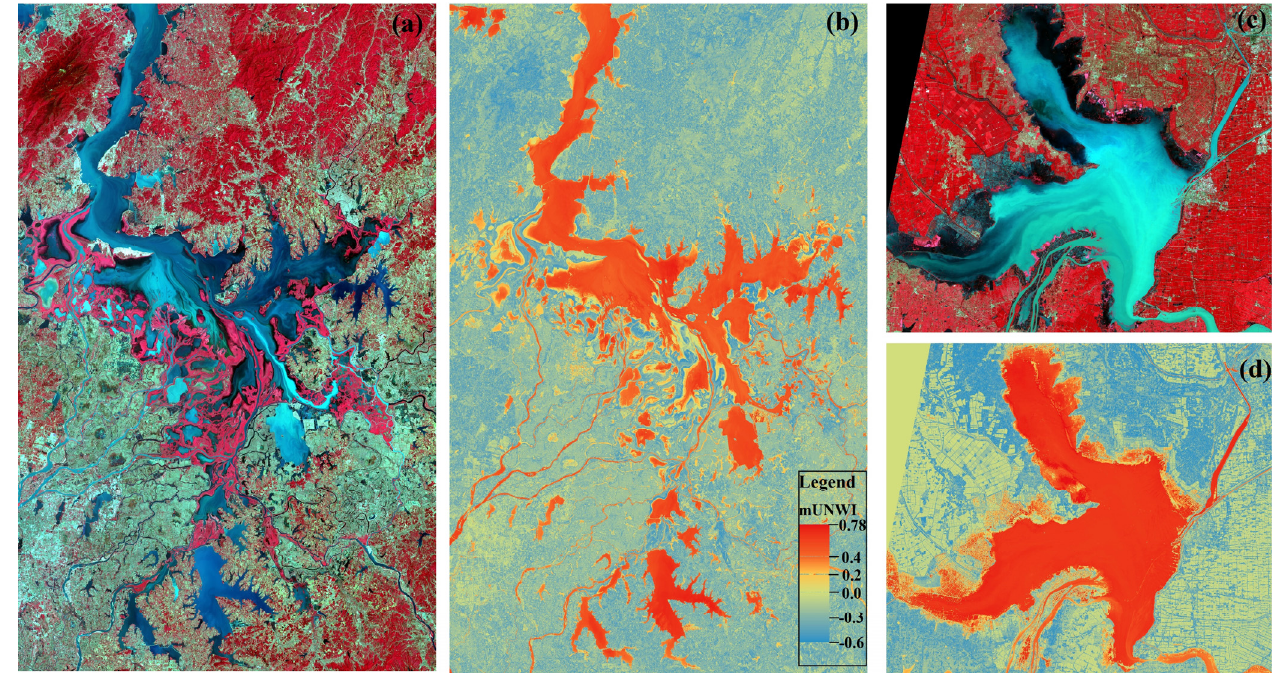
Figure 12. Landsat OLI RGB (R: 850–880 nm, G: 640–670 nm, B: 530–590 nm) composition image acquired on 15 April 2020 ( a ) and ( b ) UNWI image in Poyang Lake; acquired on 1 October 2014 ( c ) and ( d ) UNWI image in Hongze.